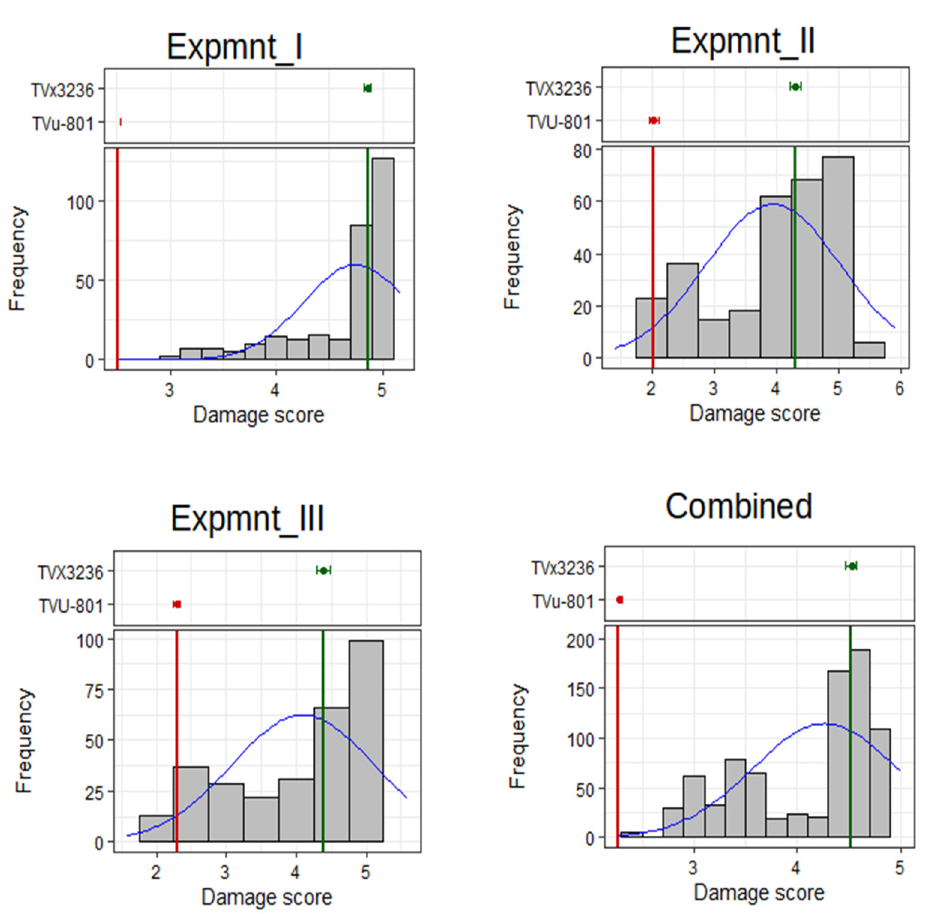
Figure 2. Phenotypic distributions for aphid damage severity in the cowpea mini-core population that were evaluated in three screenhouse experiments. The positions of the resistant check TVu-801 and the susceptible check TVx3236 are shown by the red and green vertical lines, respectively. Table 2. Genetic variability statistics for aphid damage severity in the cowpea mini-core population evaluated in three screenhouse